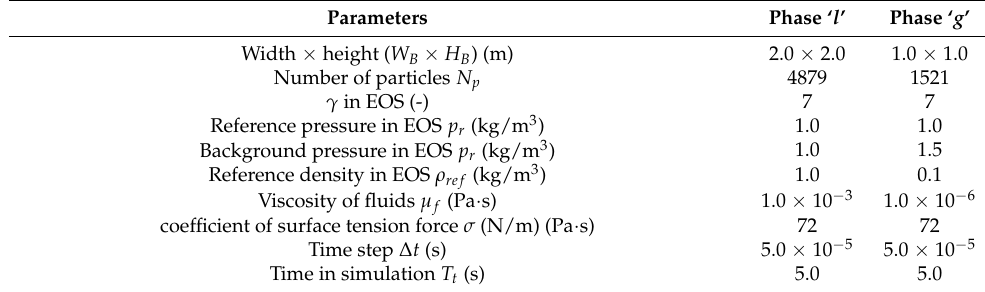
Table 2. Parameters used in the case of a square bubble in a two-phase system.